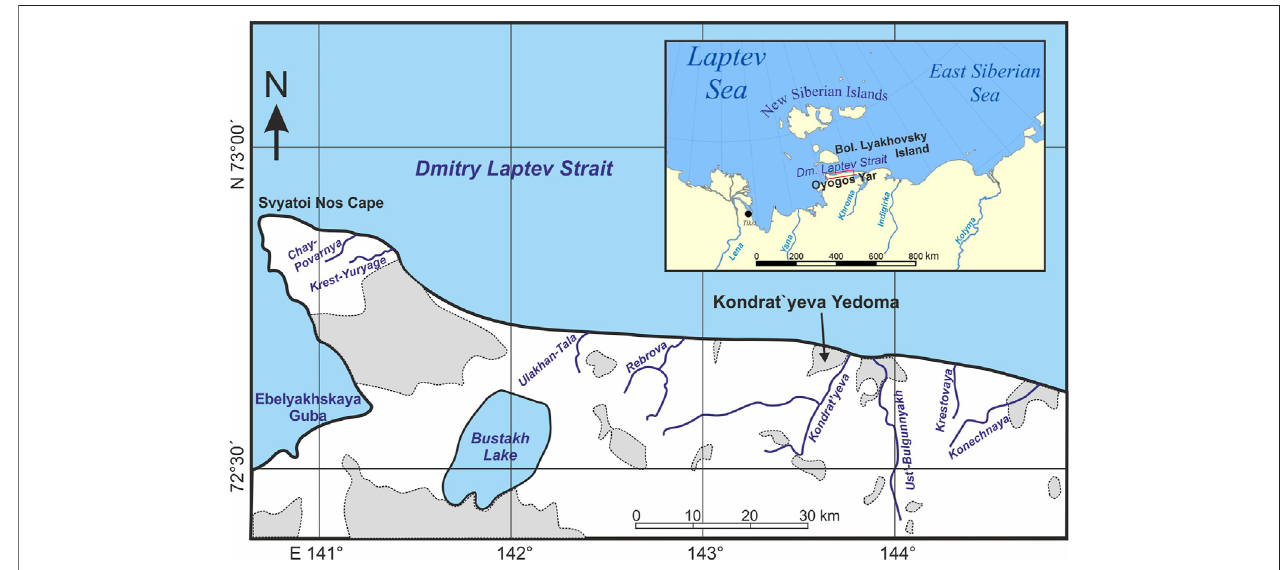
FIGURE 1 | Location map of the study region. The gray areas with dotted outlines are Yedoma